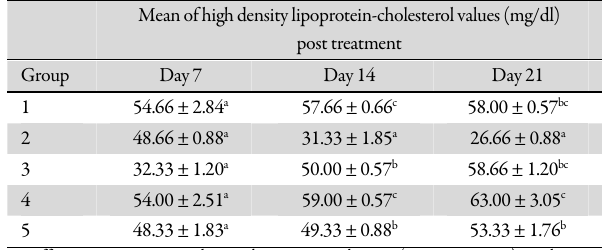
Different superscript along the same column (across groups) indicate significant difference at p < 0.05 Table 7. The mean of very low density lipoprotein-cholesterol values of alloxan induced diabetic rats treated with combinations of glibenclamide and aqueous extract of G. latifolium Mean of very low density lipoprotein-cholesterol values